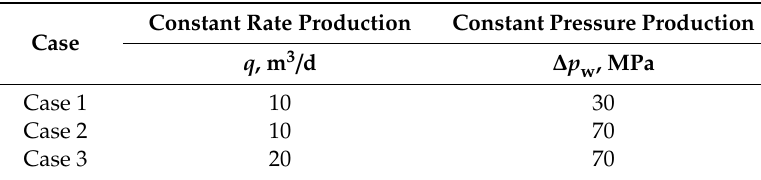
Table 8. Production histories of cases for a vertical well first producing at a constant rate and then producing at a constant pressure.